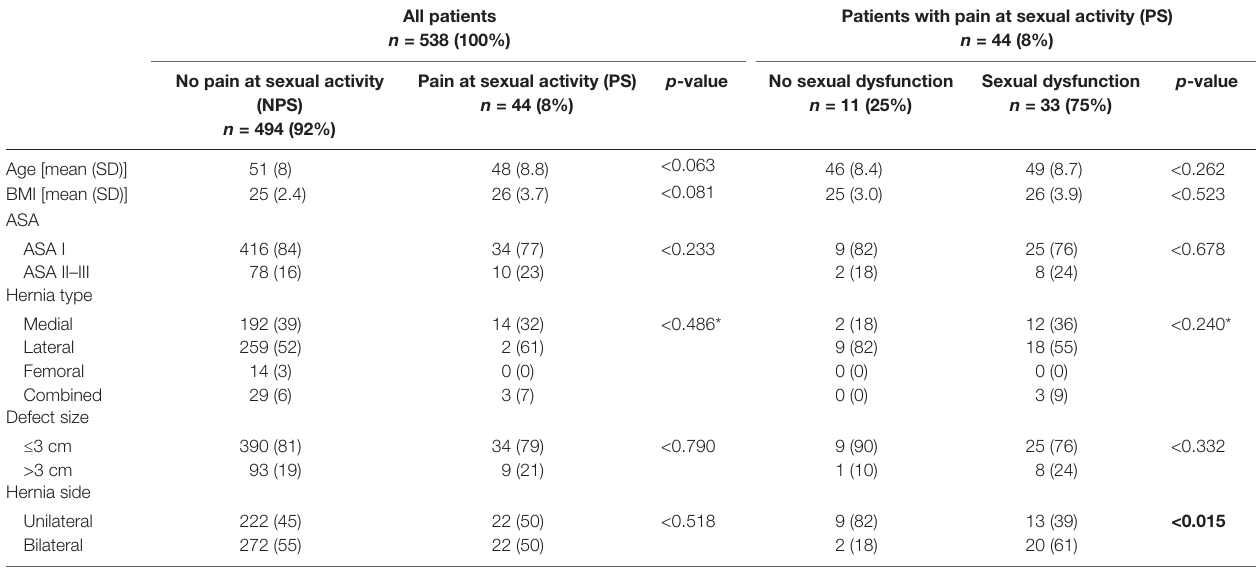
Table 1 | Patient characteristics.